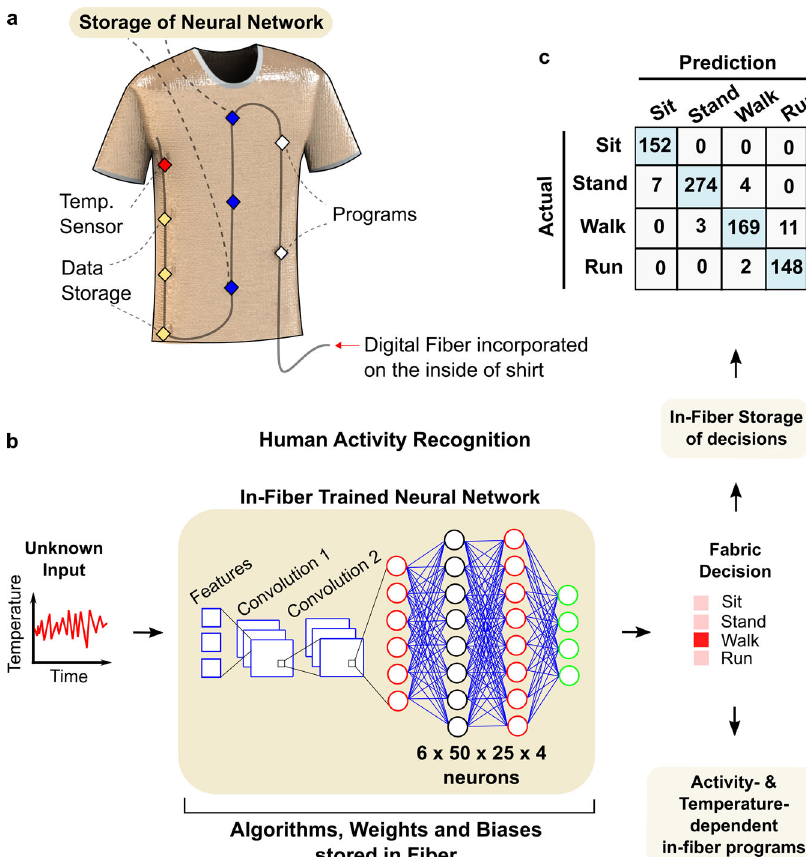
Fig. 5 Fabric with incorporated neural network capabilities. a Schematic of the shirt integrated with a digital fi bre that has sensors, data storage, customisable programmes, and a neural network stored within its memory devices. b This digital fabric is capable of running a neural network that recognises what the wearer is doing in real-time without any human intervention. The operation of the neural network is as follows: a 12-s temperature measurement is measured in real-time and inputted into the in- fi bre convolutional neural network (CNN) which is comprised of feature extraction, two convolutional layers, and four neuronal layers. After these layers, the fi bre gives a fi nal decision on the type of activity performed by the wearer. Upon decision-making, custom activity- and temperature-dependent programmes, stored in the fi bre, provide feedback on the wearer ’ s physiological status (Supplementary Fig. 11). c The accuracy of human activity recognition by the in-fabric CNN is shown by the prediction table, indicating an average accuracy of